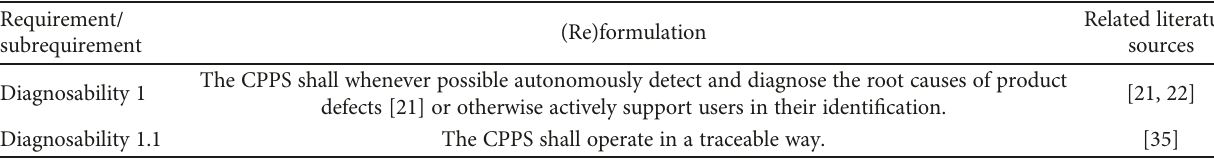
Table 6: Synthesis and reformulation of requirements on diagnosability.